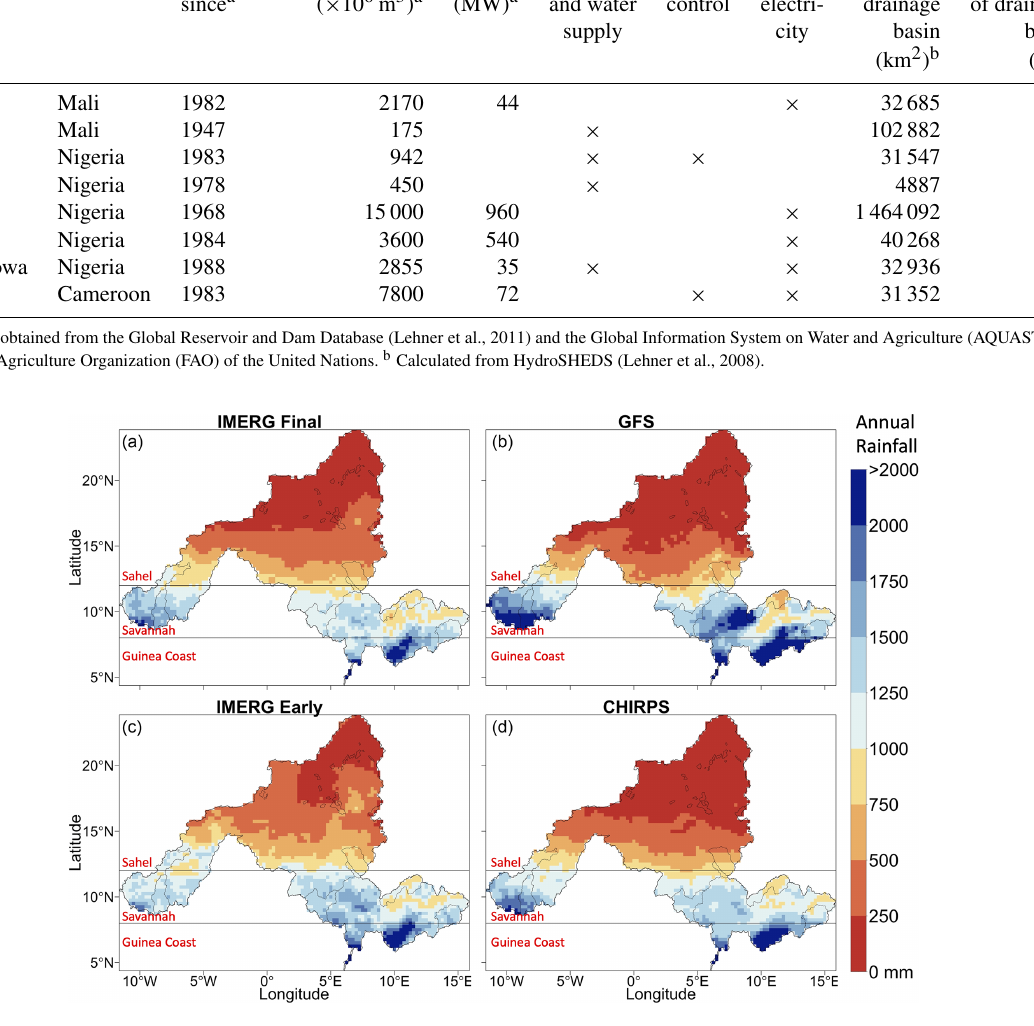
Figure 2. Spatial map of annual rainfall (in millimeters), for the period 15 June 2019 to 15 June 2020, derived from (a) IMERG